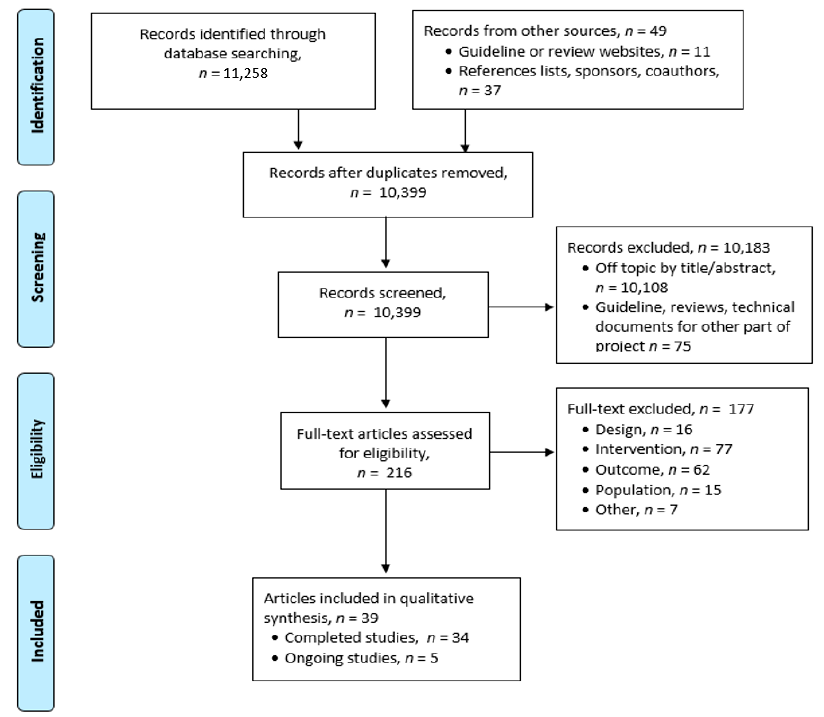
Figure 1. PRISMA Flow Diagram.